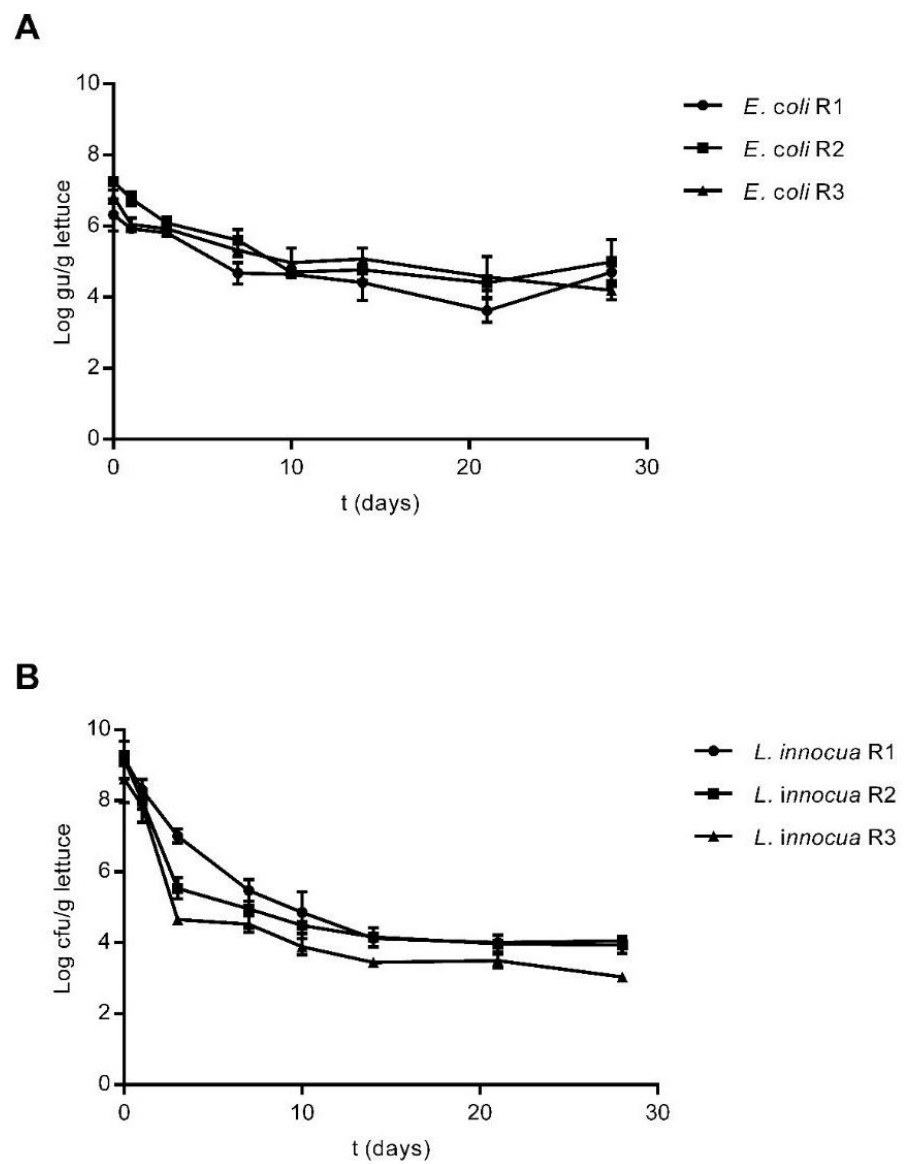
Figure 2. Survival of E. coli Lys9 StrepR ( A ) and L. innocua ATCC 51472 StrepR ( B ) on lettuce plants after a single contamination event with spiked irrigation water, as determined by qPCR up to 28 days after inoculation. Three plants were sampled at each sampling point from each plot and analysed individually, and the error bars at each time point represent the standard deviation between these technical replicates. Results are presented as Log 10 gu/g of plant material.